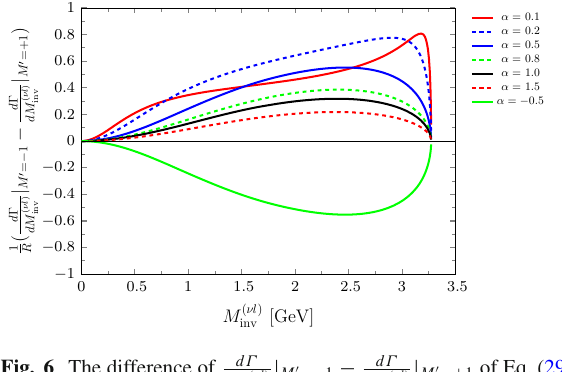
Fig. 6 The difference of d Γ a function of α , divided by the total differential width R